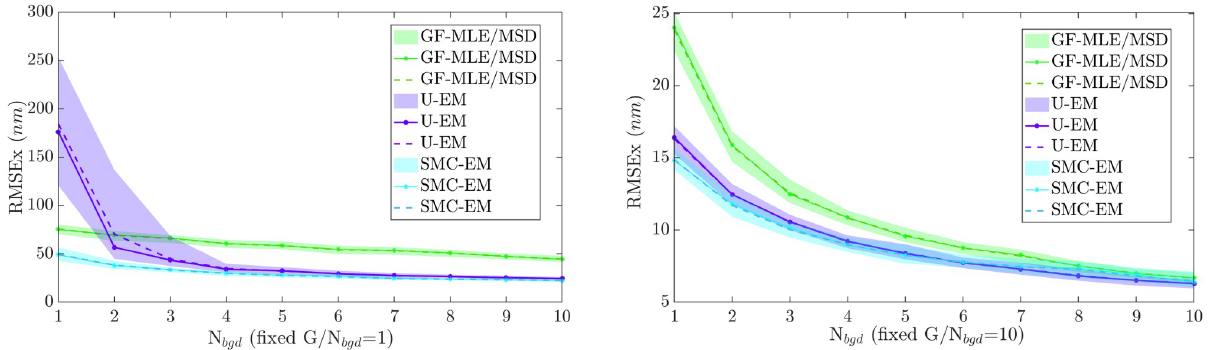
Fig 9. Localization performance (RMSE) over 100 simulation runs at different signal and background levels. With fixed (left) SBR = 1 and (right) SBR = 10. Shown are the middle two quantiles (colored, shaded area), median (solid line), and mean (dashed line). GF (green), U-EM (purple), and SMC-EM 500 (cyan).